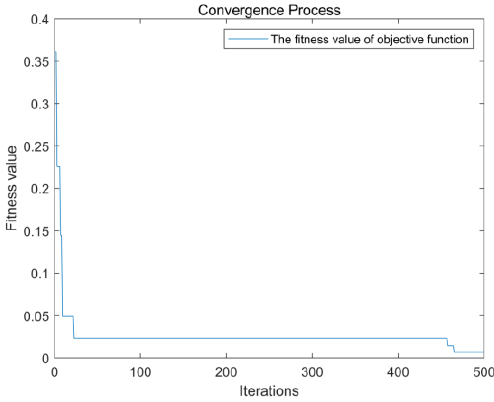
Figure 17. Particle swarm algorithm iteration diagram.